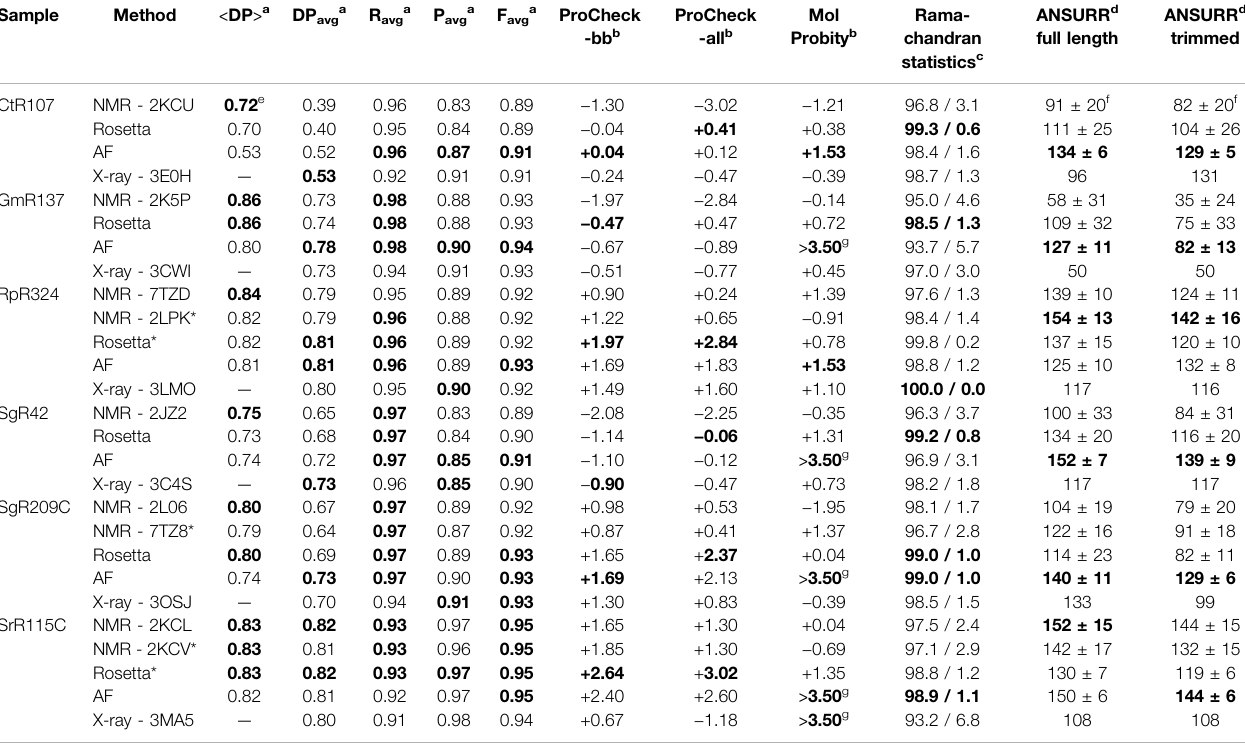
TABLE 2 | Structure quality statistics for experimental and predicted protein structures. Sample